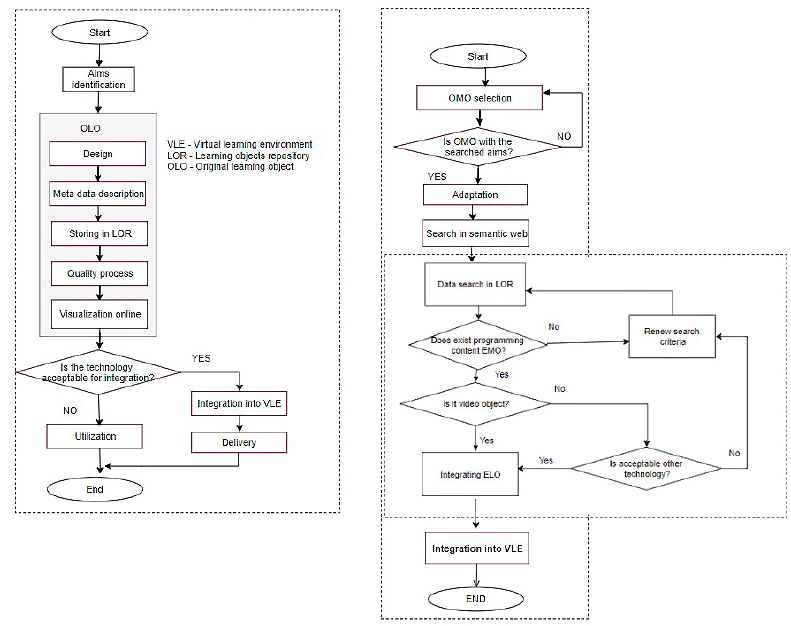
Figure 3 ELOs design, search and adaptation in the multifunctional platform. Figure 3. ELOs design, search and adaptation in the multifunctional